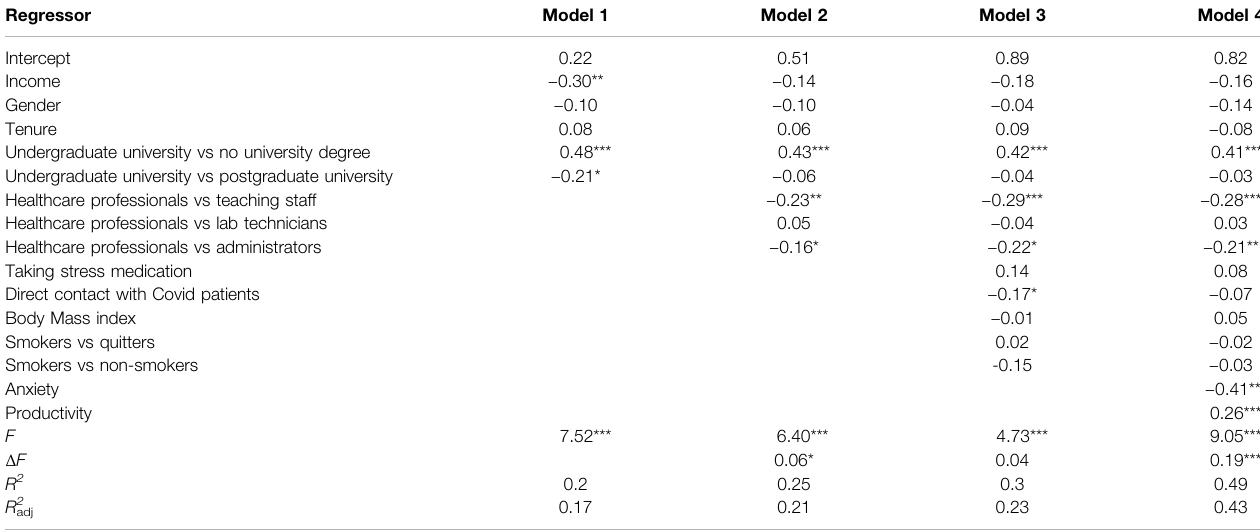
TABLE 3 | Regression Model for compliance.